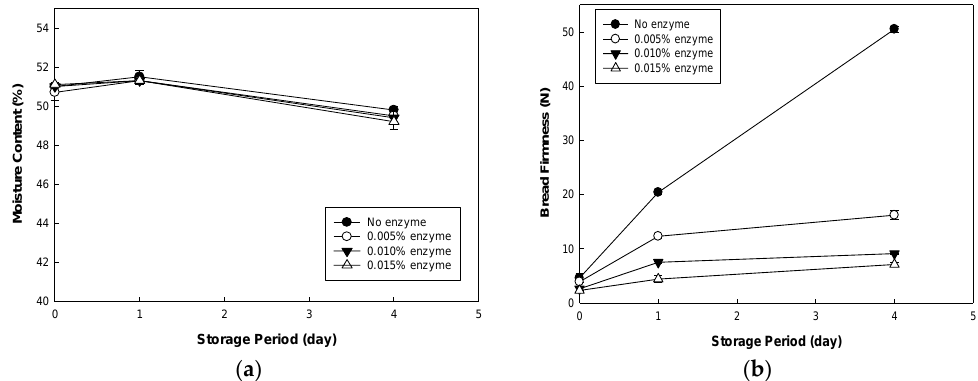
Figure 4. Changes in the moisture content ( a ) and firmness ( b ) of bread with anti-staling enzyme at different concentrations during storage at 4 °C. Table 4. Thermal characteristics of gluten-free rice bread prepared with #11 (1% gum, 100 g of water, a 5 min mixing time, and a 60 min fermentation time) during storage at 4 °C.